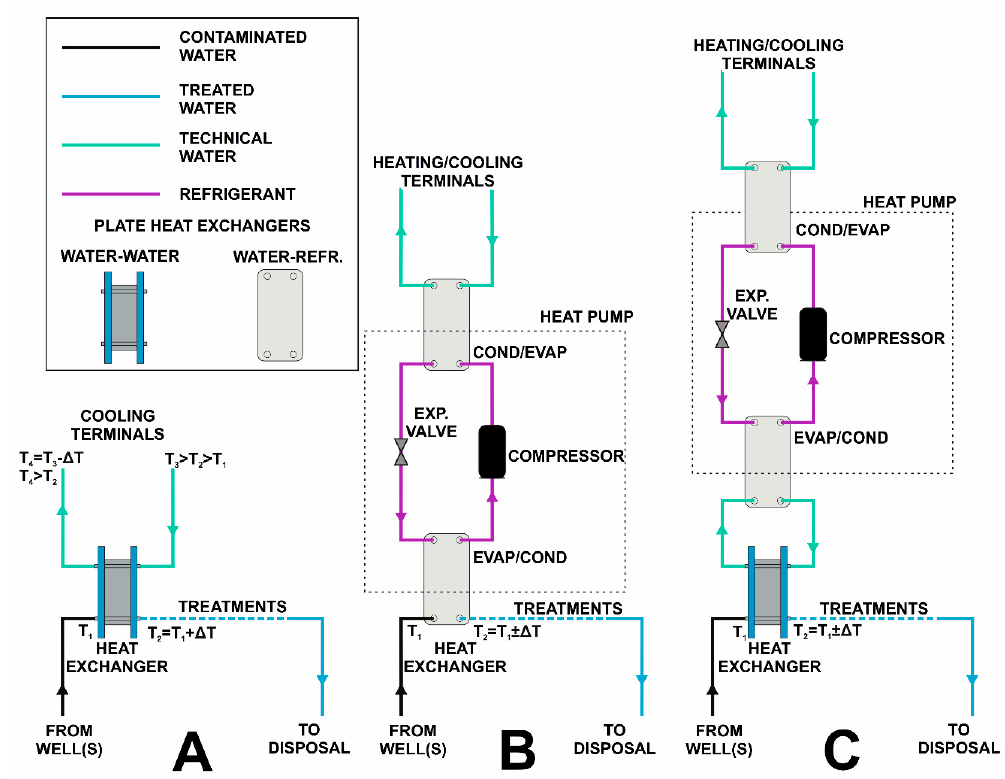
Figure 1. Possible heat uses for P&T systems: ( A ) direct heat exchange for cooling; ( B ) heat pump directly connected to the well loop; ( C ) heat pump connected to the well loop through an intermediate heat exchanger.